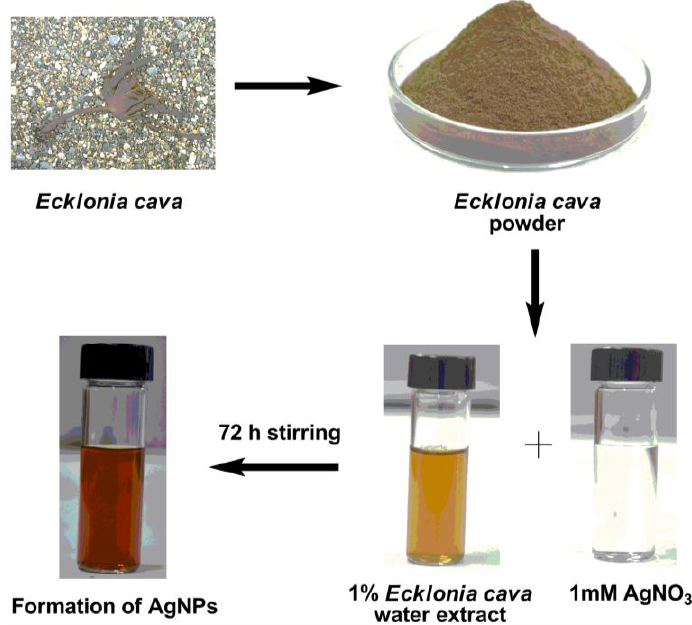
Figure 2. Schematic representation of green synthesis of AgNPs. Ecklonia cava is collected from the sea and then ground into a fine powder. The aqueous extract of Ecklonia cava is mixed with 1 mM AgNO 3 solution and stirred for 72 h to synthesize AgNPs.